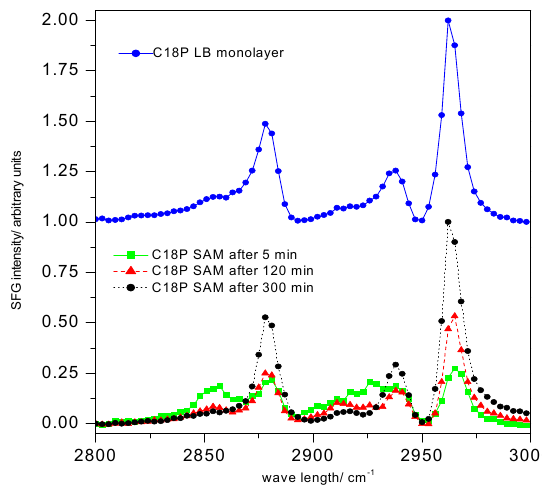
Figure 5. Sum frequency vibrational spectra (SFG) of stearoyl phosphonic acid (C18P) nanolayers (C18P SAM); the upper curve shows the C18P Langmuir–Blodgett (C18P LB) layer’s spectrum; the lower part demonstrates the influence of the stearoyl phosphonic acid SAM layer formation time (5, 120, 300 min) on the spectra; (abbreviation: e.g., C18P SAM 5 means that the stearoyl phosphonic acid SAM layer formed in 5 min) (spectra collected by EKSPLA (Vilnius, Lithuania) sum frequency spectrometer; visible beam: 532 nm generated by output of a Nd:YAG laser (1064 nm), 20 ps pulse